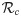
Change in the local control reproduction number Rc with varying ρht, ρc and ρt.(a) Change in Rc with low ρht and varying ρc and ρt, (b) Change in Rc with high ρht and varying ρc and ρt, (c) Change in Rc with low ρc and varying ρht and ρt, (d) Change in Rc with high ρc and varying ρht and ρt, (e) Change in Rc with low ρt and varying ρht and ρc, (f) Change in Rc with high ρt and varying ρht and ρc.